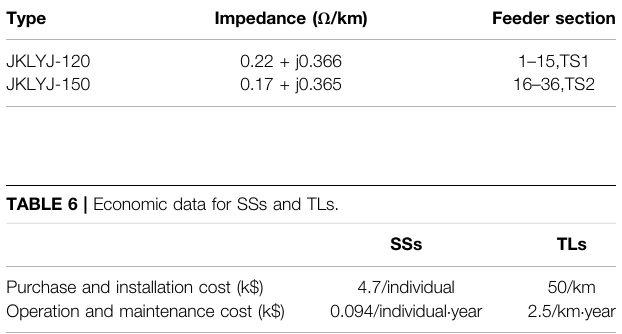
TABLE 7 | Speci fi cations of distribution fault type.